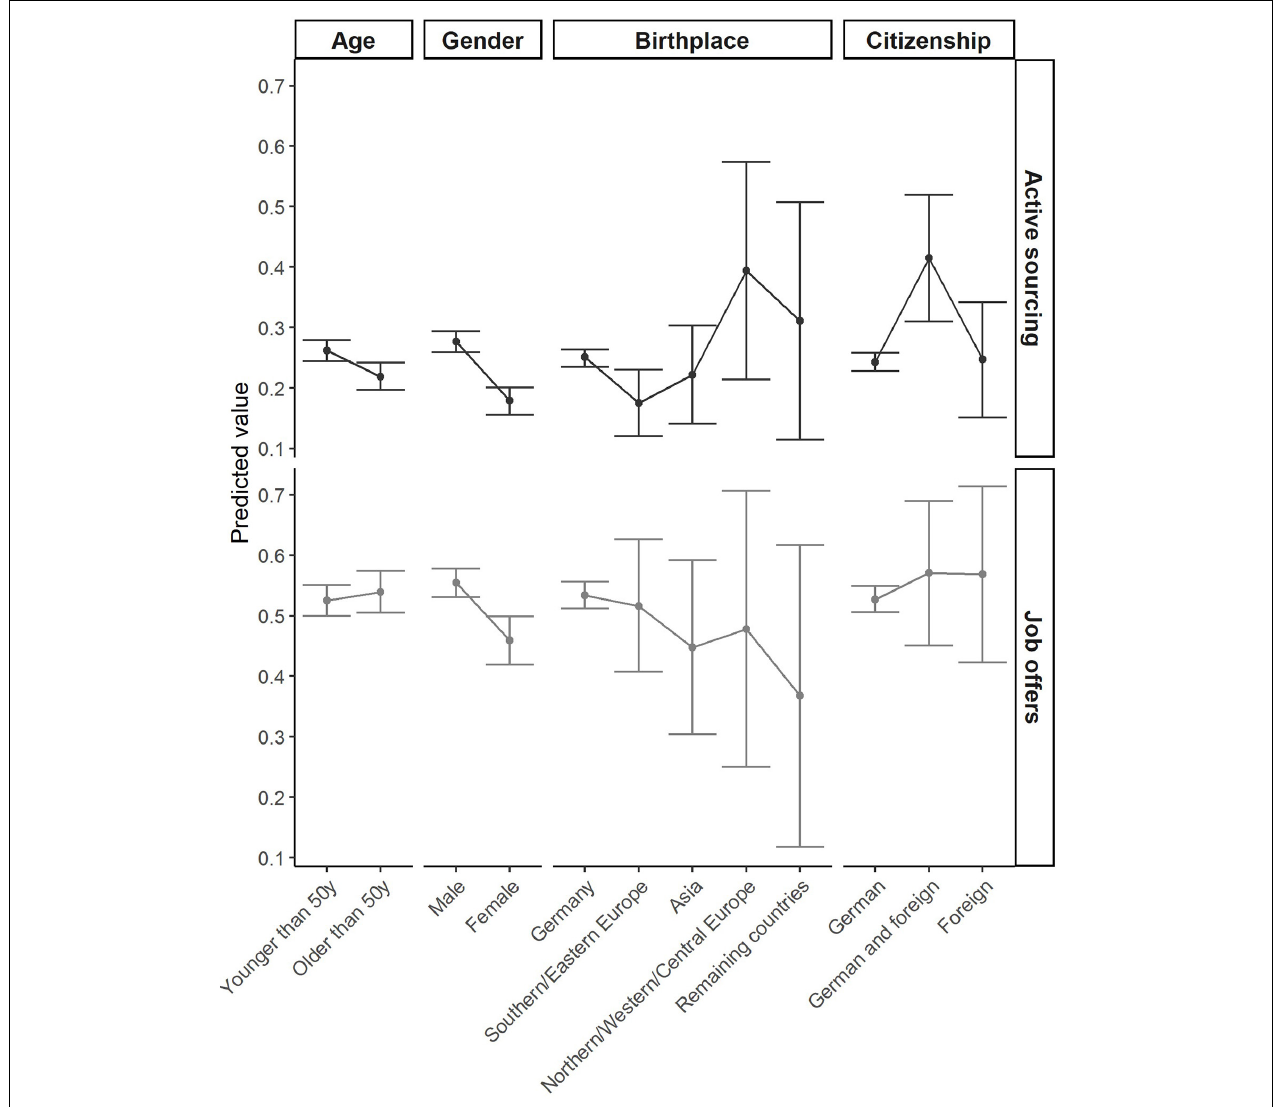
FIGURE 3 | Predicted values for the two dependent variables, active sourcing (DV1) and job offers (DV2). The first row of boxes refers to active sourcing, the second row to job offers. The dots represent the predicted values, the angled lines represent the 95% confidence interval. The reference categories are younger than 50 years for age, male for gender, Germany for birthplace, and German for